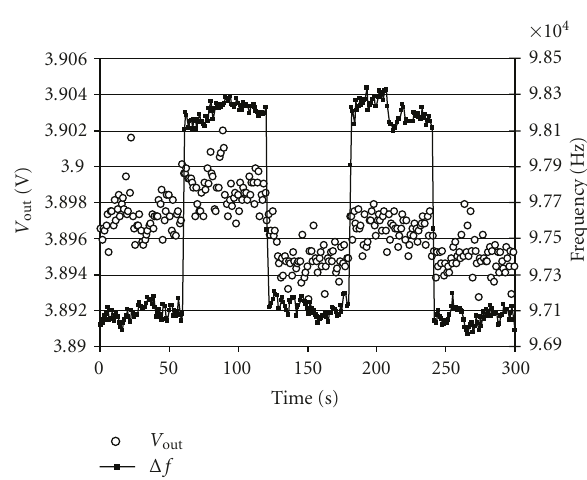
Figure 6: V out from analogue bu ff er stage versus. Frequency shift for Δ V out = 2 . 0